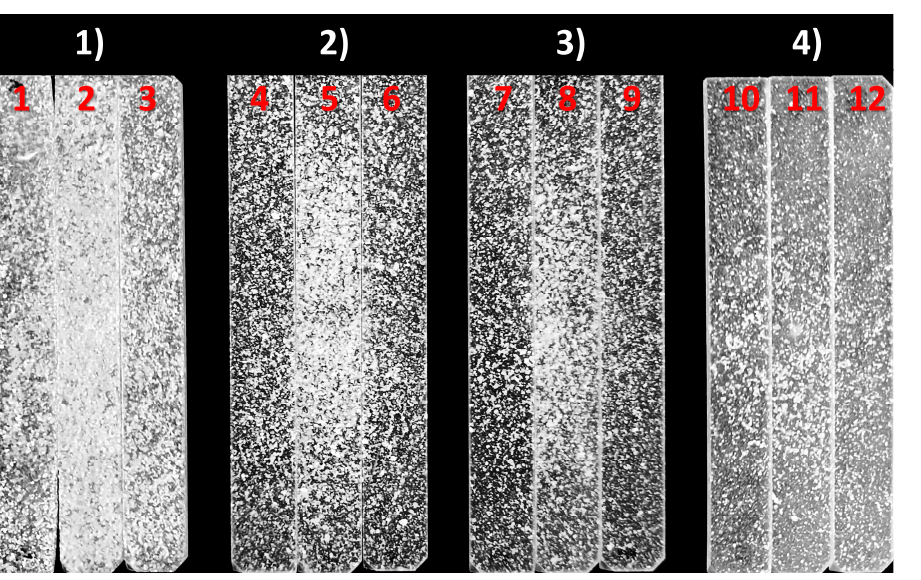
Figure 2. An illustrative image of 12 composite samples from series: (1), (2), (3), (4).